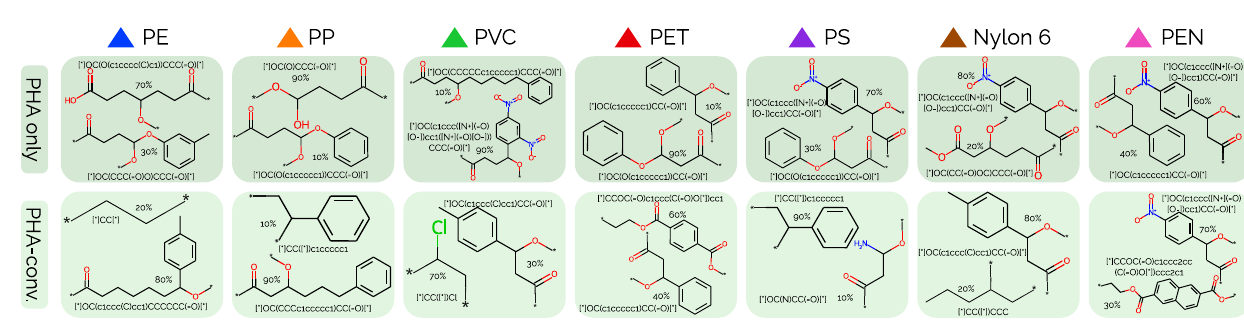
Fig. 4 PHA-only and PHA-conventional bio-replacements for seven commodity plastics. Full polymer names are listed in Table